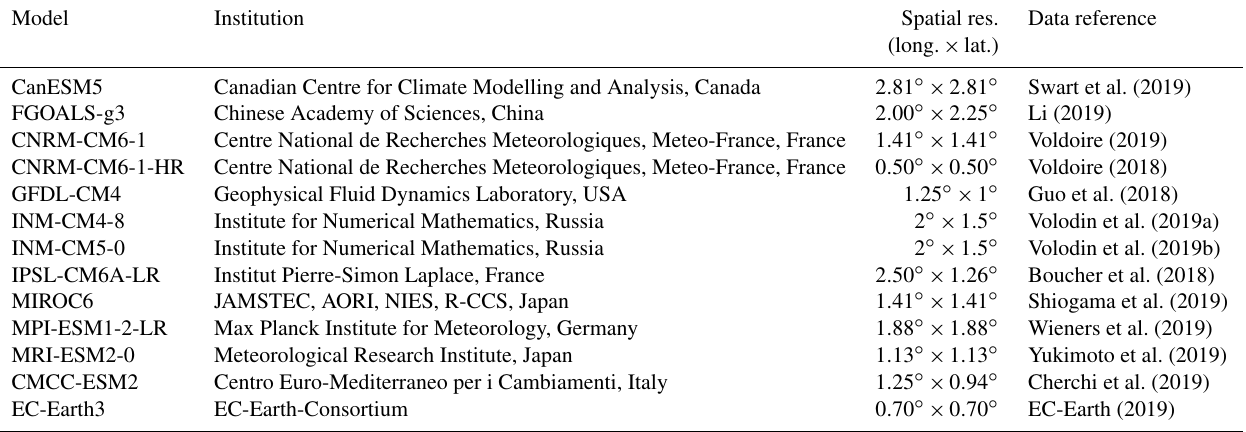
Table 1. List of CMIP6 simulations used in this study, their run, approximate horizontal resolution and references.